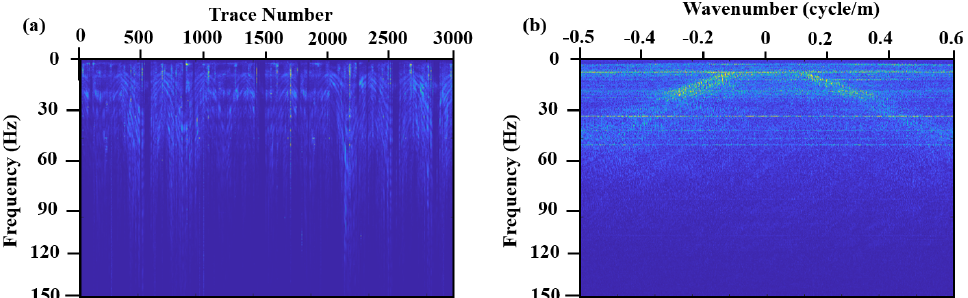
Figure 3. The real data in different transform domains: ( a ) f-x spectra; ( b ) f-k